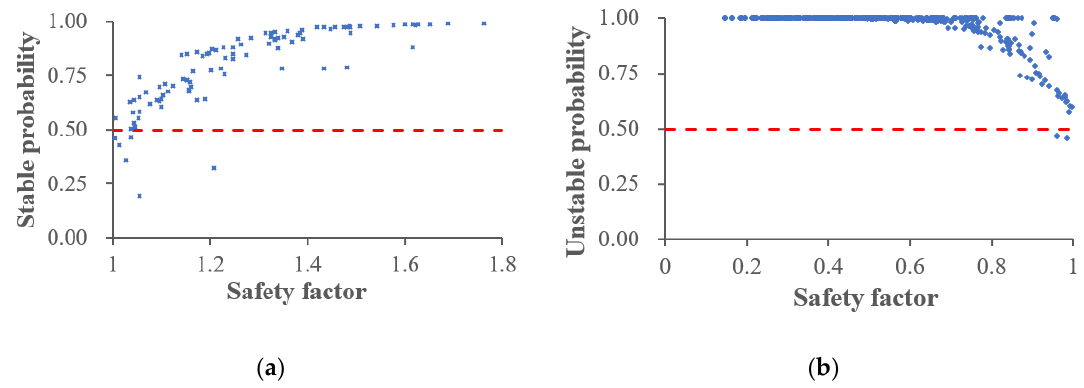
Figure 10. Error estimation for the second classifier. ( a ) Stable probability of the samples with F s ≥ 1; ( b ) unstable probability of the samples with F s < 1.